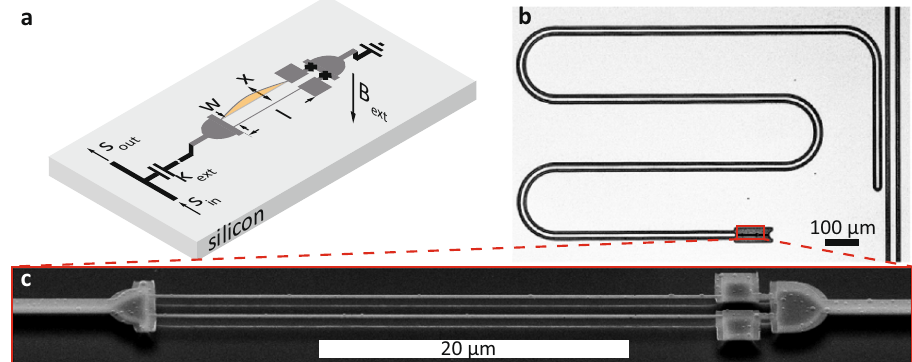
Fig. 1 Sample schematic and device images. Panel a shows a schematic of the device. The superconducting λ /4-coplanar microwave resonator is coupled capacitively with a coupling rate κ ext to a microwave transmission line acting as feed-line, where S in and S out denote the microwave input and output signal. A dc-SQUID with two freely suspended arms, which are separated by w , shunts the resonator to ground on the other end. The resonance frequency is tunable by varying the fl ux through the SQUID loop, e.g., by adjusting the external magnetic fi eld B ext . In addition, the freely suspended SQUID arms (strings) modulate the SQUID inductance with the mechanical frequency via a change in the area of the SQUID loop and hereby realize the electromechanical coupling. In total, we expect the presence of four mechanical modes (one in- and one out-of-plane for each of the two strings) in our device. In our experiments, we focus only on one of them as sketched in panel ( a ). Panel b shows a microscope image of the aluminum resonator with the SQUID located at one end fabricated using a lift-off process. Panel c shows a tilted scanning electron microscope (SEM) image of a similar partly suspended SQUID structure. Note that the strings investigated in this work have dimensions of 20 μ m × 110 nm × 200